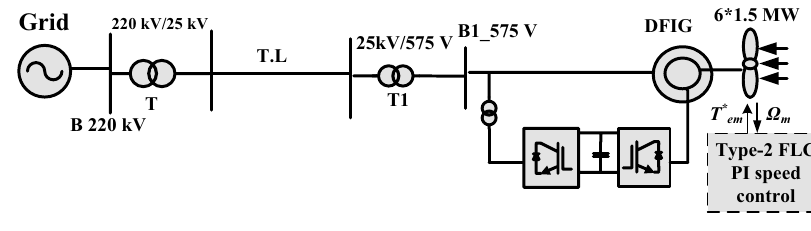
Fig. 9 Configuration of the studied wind farm